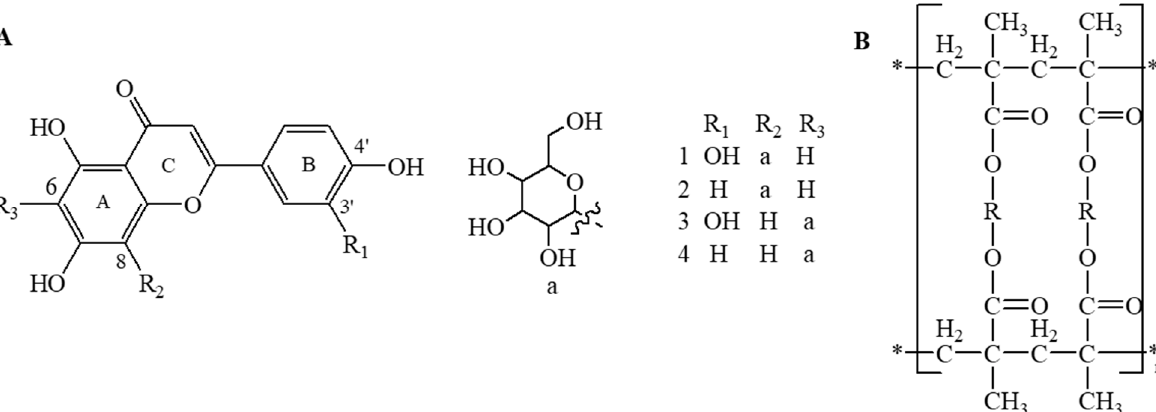
Figure 1. ( A ) Structures of C -glycosyl flavonoids identified in oil palm leaves (OPL): orientin (1), vitexin (2), isoorientin (3), isovitexin (4). ( B ) Structure of the XAD7HP resin. R = polyfunctional aliphatic residue.